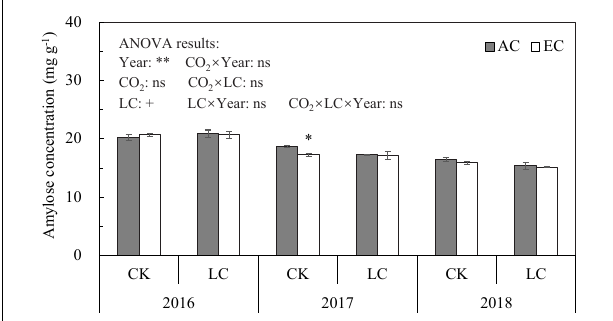
FIGURE 2 | The amylose concentration of WYJ27 as affected by elevated CO 2 under CK (no leaf cutting) and LC (cutting off top three leaves) across three cropping seasons (2016–2018). Each bar in the figure represents the mean values across three plots for ambient CO 2 (AC, filled square) or elevated CO 2 (EC, AC + 200 ppm, unfilled square); vertical bars represent standard error ( n = 3). Statistically significant effects are indicated as ∗∗ P < 0.01; ∗ P < 0.05; + P < 0.1; ns, not